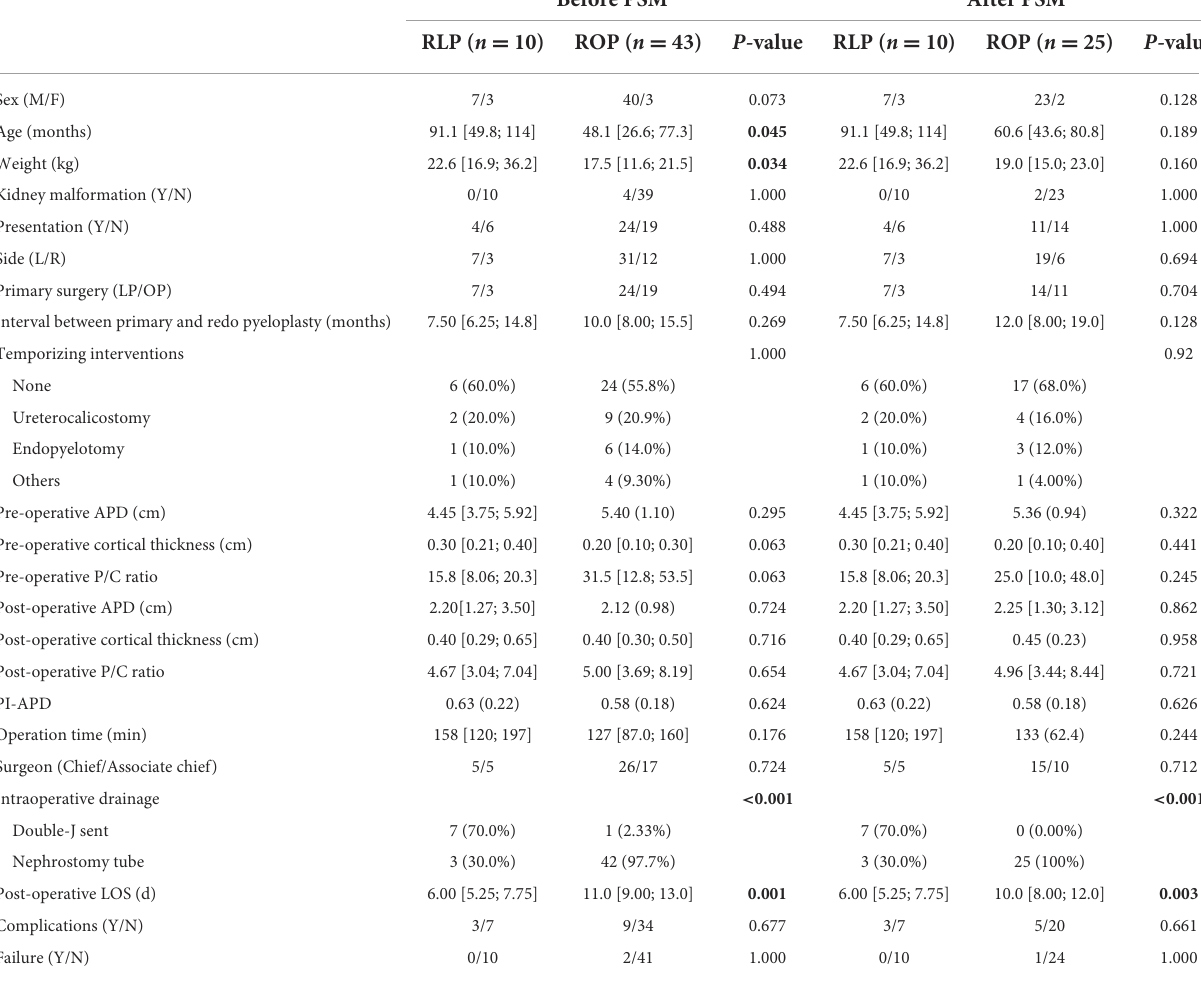
TABLE 3 Characteristics for patients underwent redo laparoscopic pyeloplasty and redo open